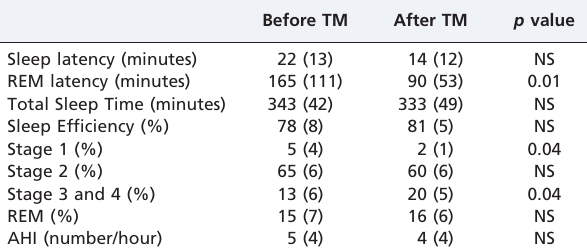
Table 1 - Polysomnography results before and after therapeutic massage